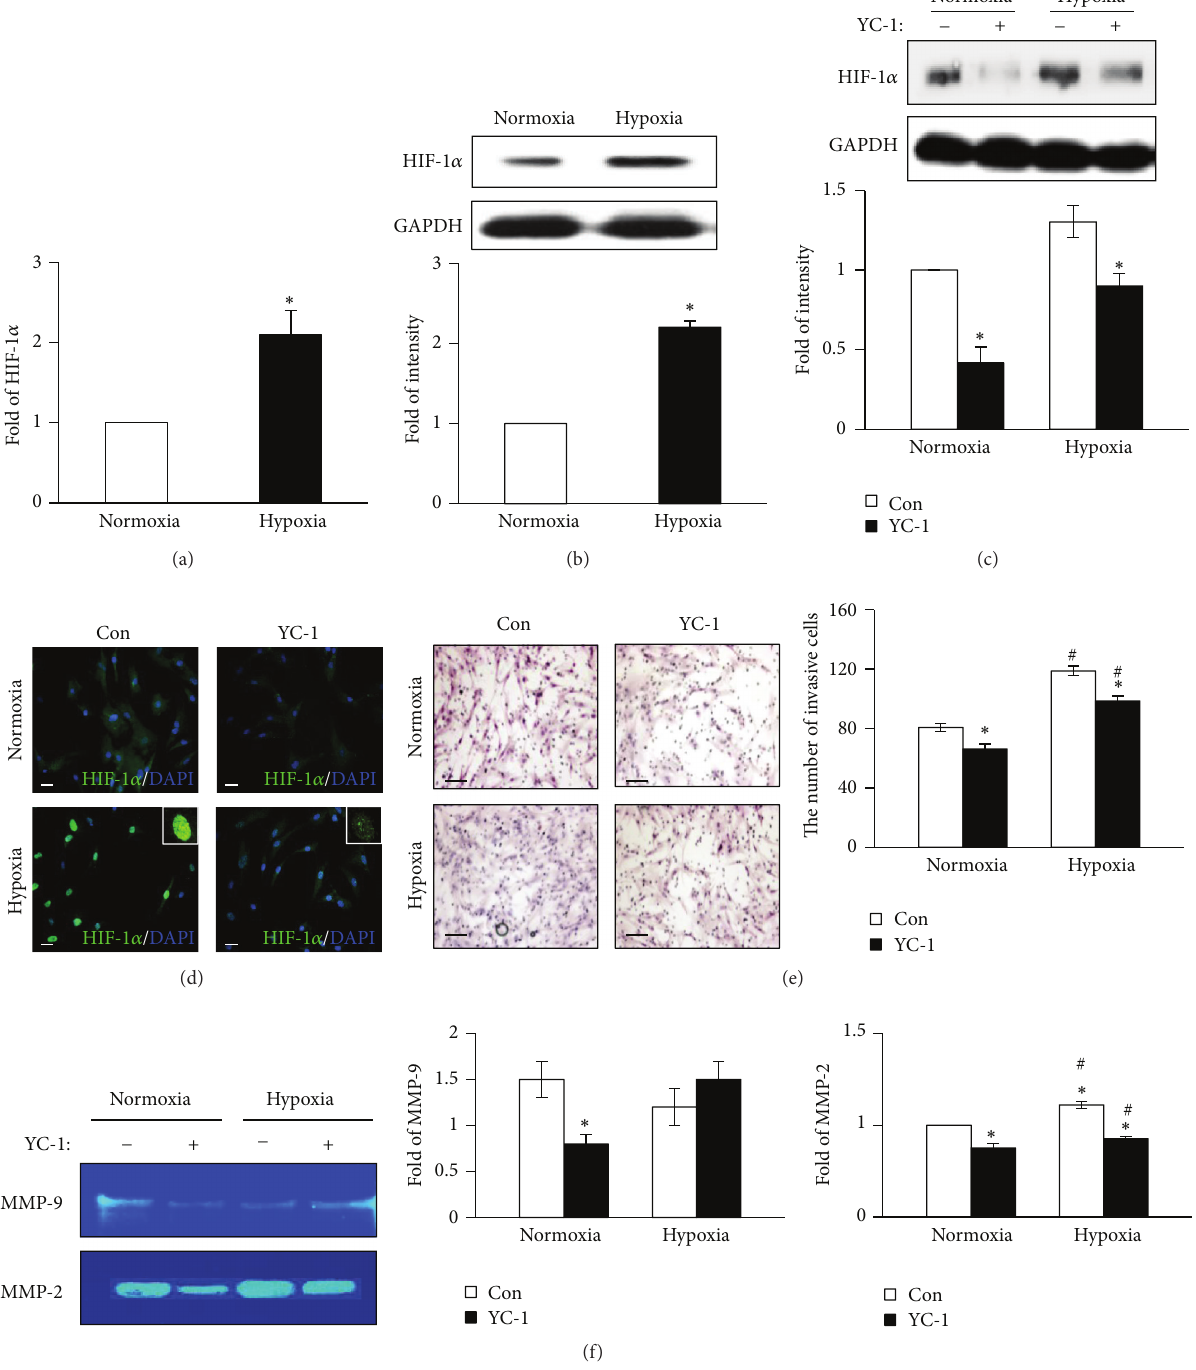
Figure 1: HIF-1 𝛼 induction by exposure to hypoxia stimulates BM-MSC migration. (a) Real-time PCR analysis showing the transcription levels of HIF-1 𝛼 in BM-MSCs under normoxic or hypoxic conditions. 18S rRNA was used as the loading control. (b) Protein expression levels of HIF-1 𝛼 in BM-MSCs under normoxic or hypoxic conditions were analyzed by Western blotting. GAPDH was used as the loading control. (c) Protein expression levels of HIF-1 𝛼 in BM-MSCs under normoxic or hypoxic conditions after pretreatment with YC-1, an inhibitor of HIF- 1 𝛼 , were analyzed by Western blotting. (d) Immunofluorescence staining showing localization of HIF-1 𝛼 in BM-MSCs after YC-1 pretreatment under normoxic or hypoxic conditions. Blue: DAPI; green: HIF-1 𝛼 . Scale bar = 80 𝜇 m (400x original magnification). (e) Invasiveness of BM- MSCs after pretreatment with YC-1 determined by invasion assay (left). Quantification of the cells invaded through the inserts (right). (f) Enzymatic activities of MMP-9 and MMP-2 in BM-MSCs under the indicated conditions analyzed by zymography (left). Quantification of enzymatic activities of MMP-9 (middle) and MMP-2 (right). ∗ 𝑃 < 0.05 (compared with YC-1 nontreated group) and # 𝑃 < 0.05 (compared with normoxic group). DAPI: 4 󸀠 ,6-diamidino-2-phenylindole; HIF-1 𝛼 : hypoxia-inducible factor-1 𝛼 ; MMP: matrix